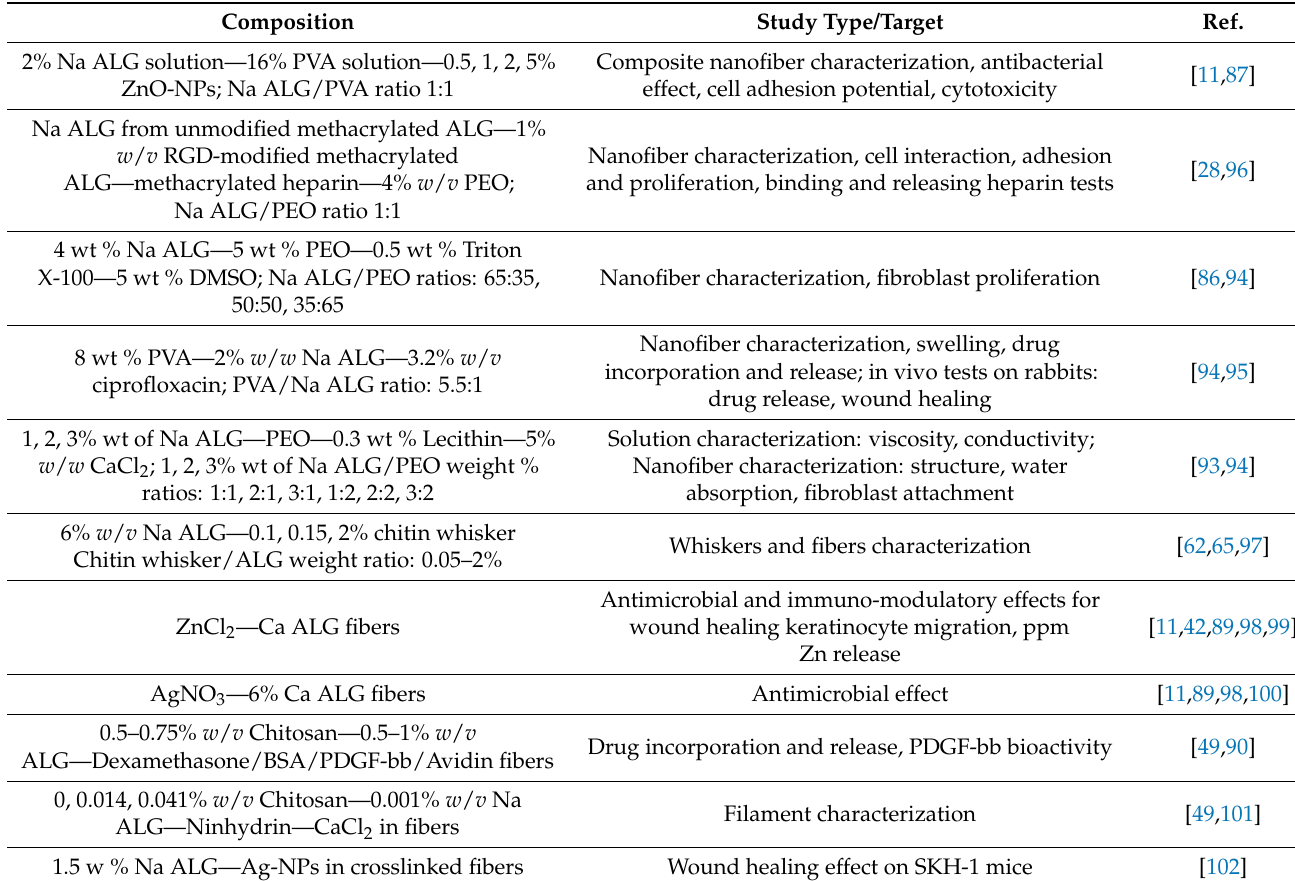
Table 3. Alginate-based nanofibers and fibers used for wound healing. Composition Study Type/Target